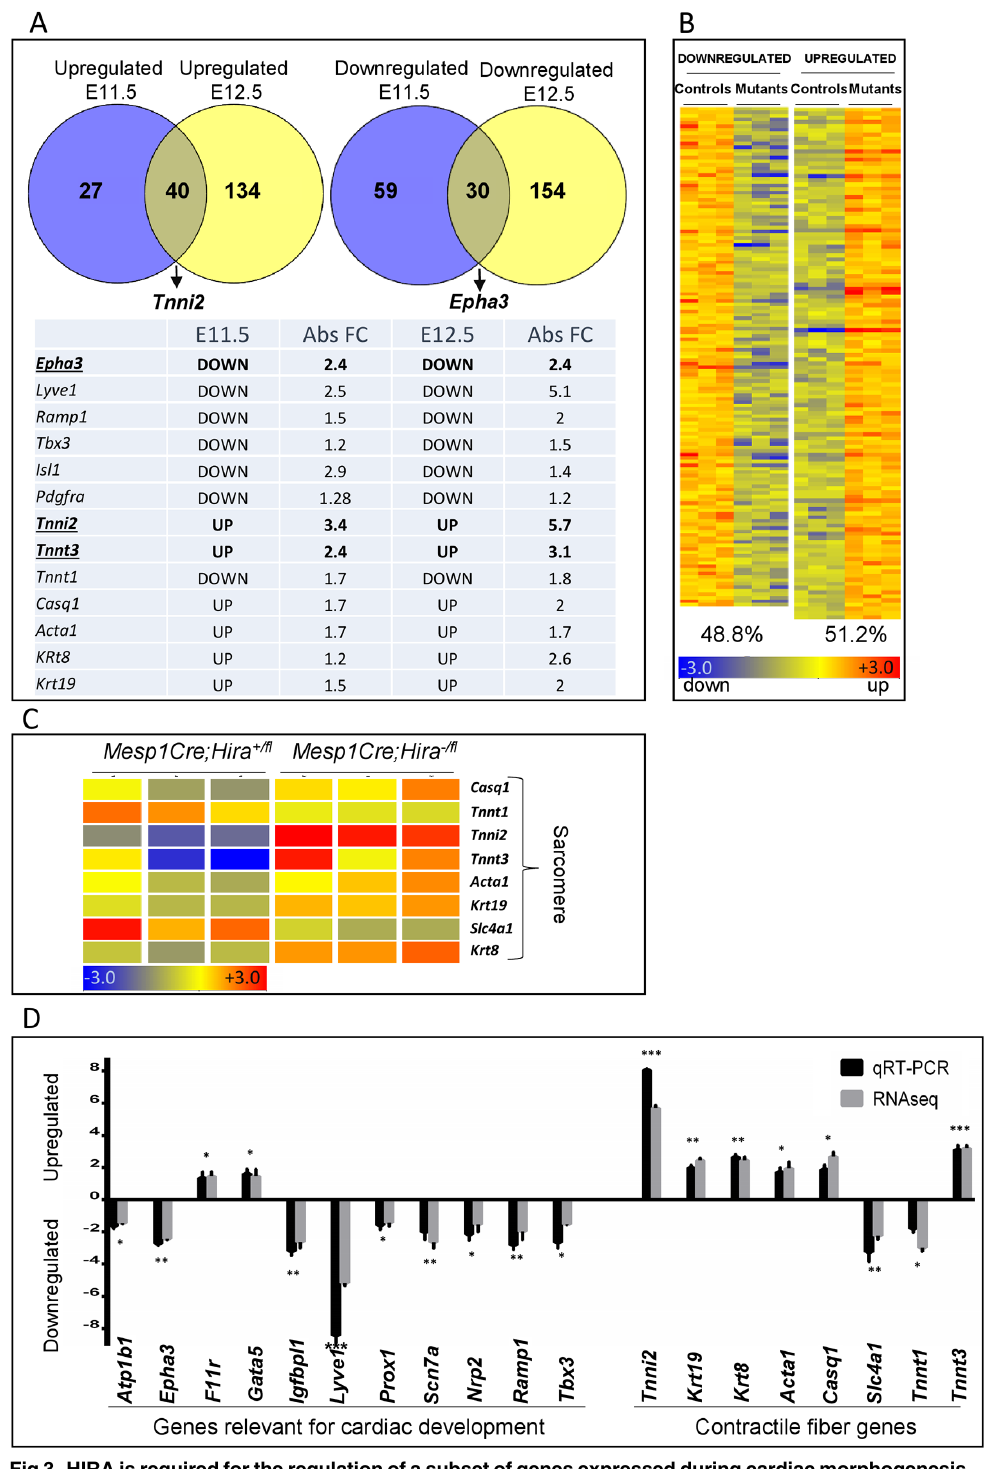
Fig 3. HIRA is required for the regulation of a subset of genes expressed during cardiac morphogenesis. A. Venn diagram indicating the number of genes whose expression is up or downregulated in Mesp1Cre ; Hira -/fl compared to Mesp1Cre ; Hira +/fl hearts at E11.5 and E12.5. The table indicates the level of fold change observed at E11.5 and at E12.5 on a subset of genes. B. Heatmap displaying the differential gene expression in mutant (Mesp1Cre ; Hira -/fl ) vs control (Mesp1Cre ; Hira +/fl ) in triplicates at E12.5. C. Heatmap of the gene ontology analysis